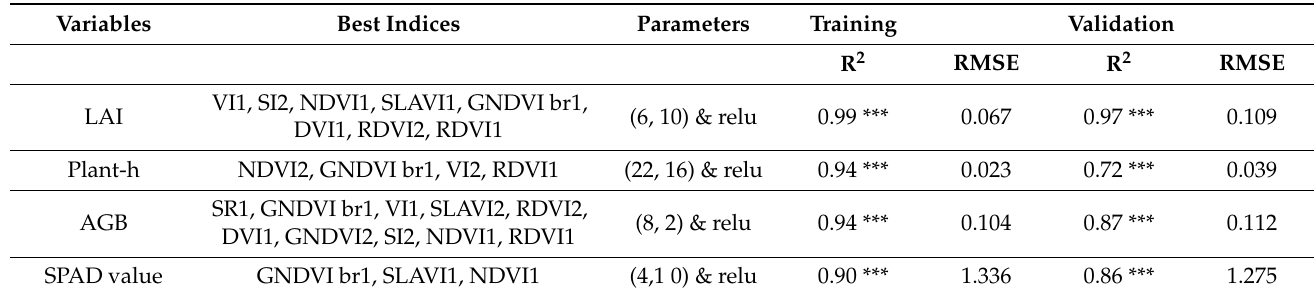
Table 9. Outcomes of calibration ( n = 96) and validation models ( n = 48) of ANN for the association between the best V-SRIs extracted from in situ spectrometry and satellite imagery and leaf area index, Plant height, above ground biomass and SPAD